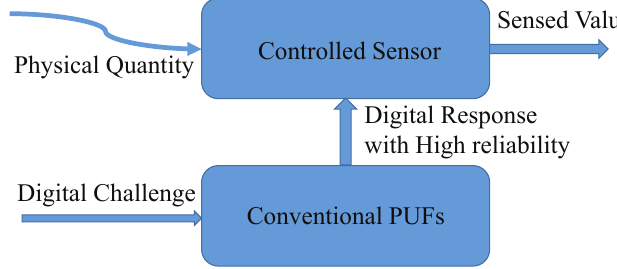
Figure 1. Physical unclonable function (PUF)-protected sensor.